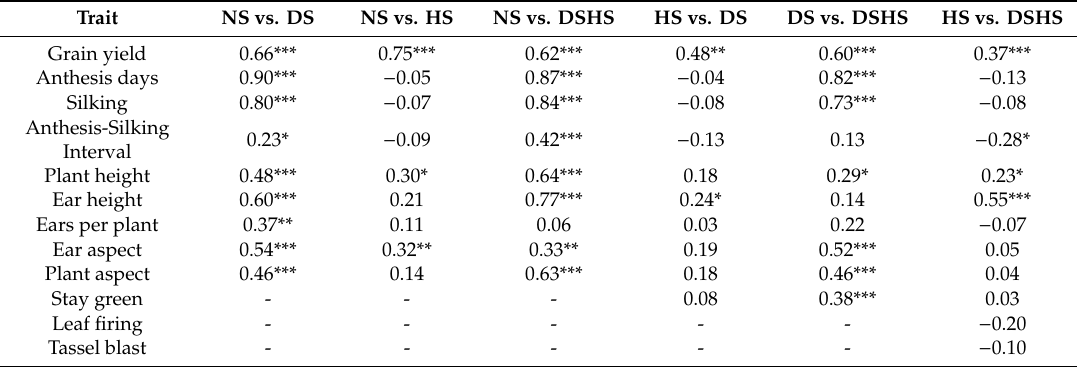
Table 3. Coe ffi cient of phenotypic correlations between treatments for traits of 72 extra-early maturing maize accessions evaluated between 2017 and 2019 in